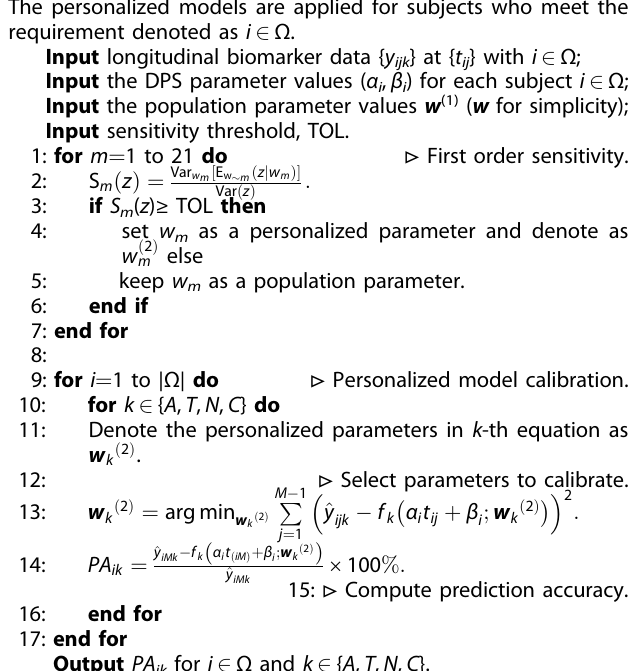
Algorithm 2 . Personalized model calibration algorithm. The personalized parameters are initialized by the population model. The personalized models are applied for subjects who meet the requirement denoted as i ∈ Ω .